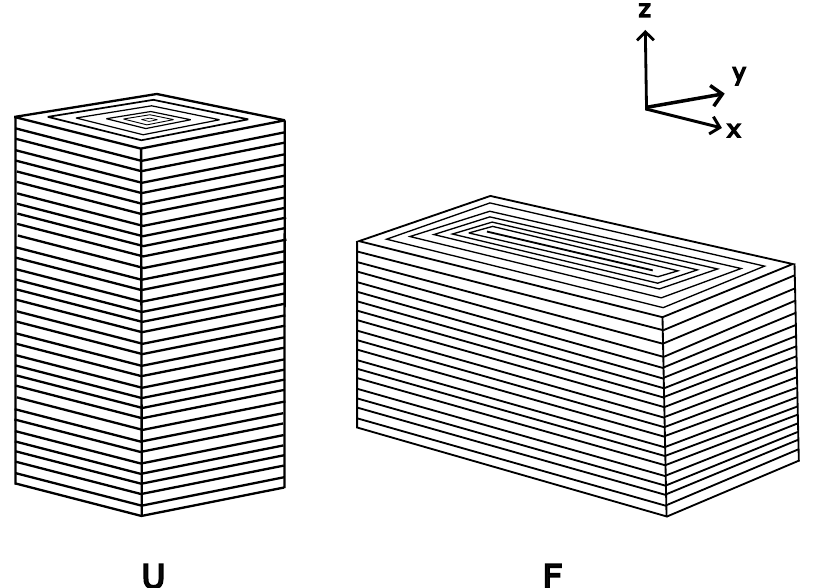
Figure 2. Infill of compression specimens. U: upright, F: